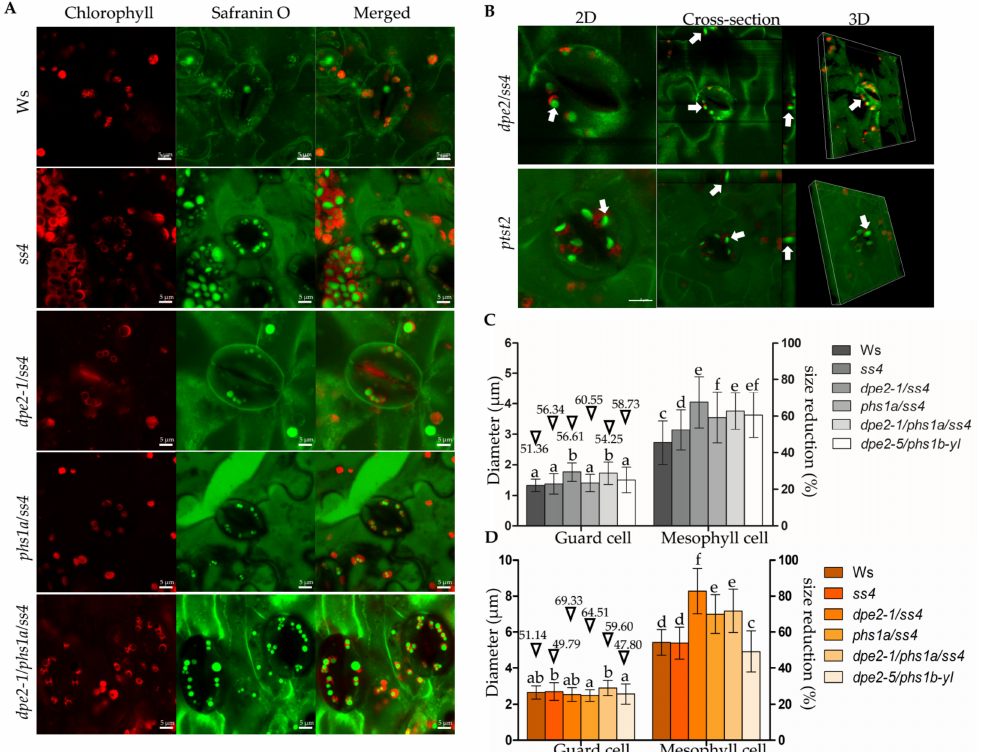
Figure 2. Starch granules in the guard cells. ( A ) Graphs were taken from 3-week-old rosette leaves in the middle of the light phase. Scale bar is equivalent to 5 µ m. ( B ) The 2D, cross-section, and 3D views of the starch granules of dpe2/ss4 and ptst2 . White arrows mark the target starch granule. ( C ) Diameters of the starch granules in the guard and mesophyll cells, n > 100. ( D ) Diameters of the chloroplasts in the guard and mesophyll cells, n = 100. ( C , D ) The mean and SD calculated from 50 values. Letters indicate the statistically significant differences ( p ≤ 0.05) according to the one-way ANOVA with Tukey’s post-hoc test. Inverted triangles and corresponding values indicate the percentage of the size reduction in the starch granules ( C ) and chloroplasts ( D ) in the guard cells compared with the mesophyll cells.